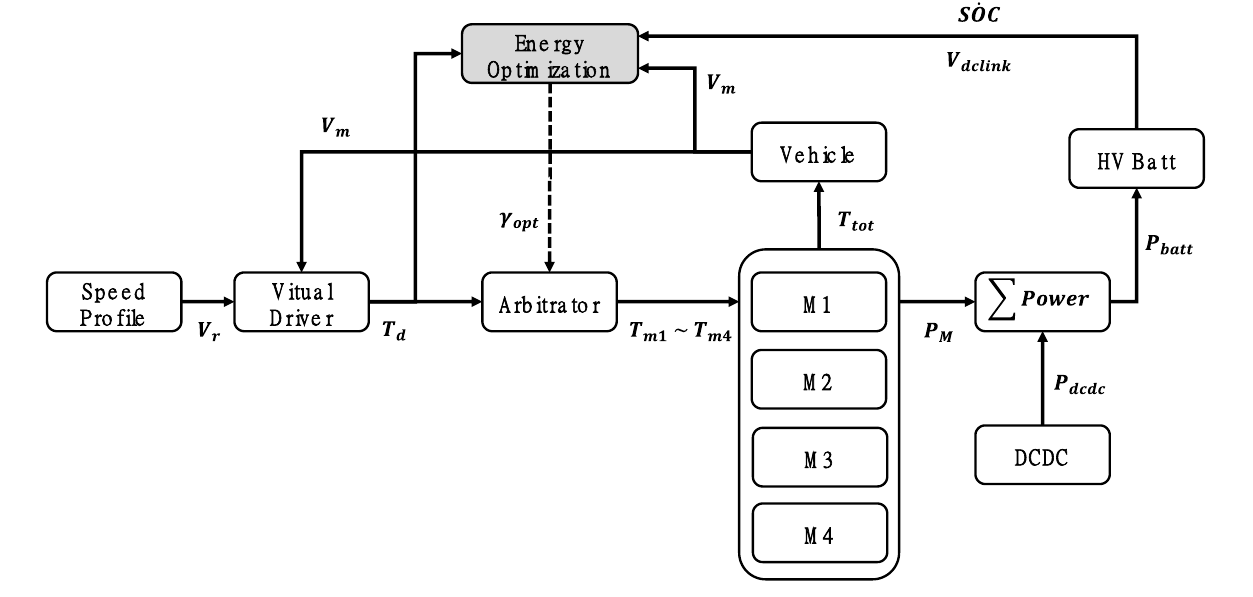
Figure 9. Energy optimization concept diagram.